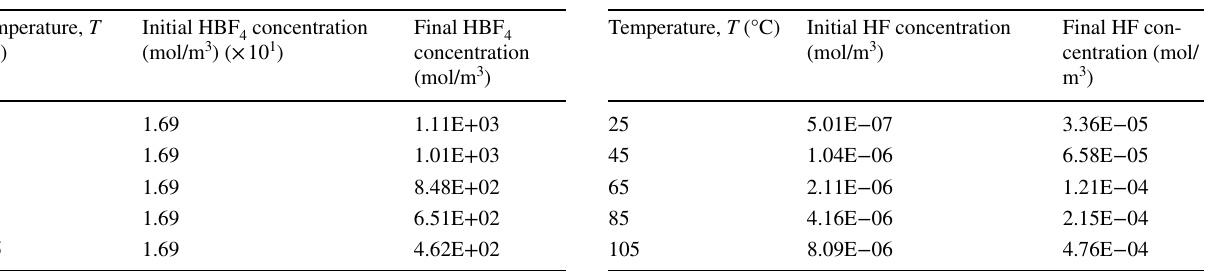
4 concentration